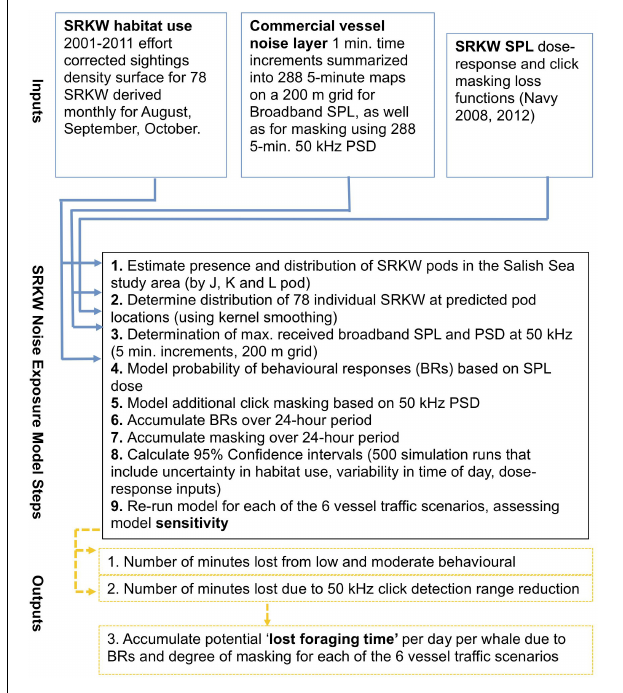
FIGURE 3 | Explanation and pseudocode of noise-exposure simulation model. More details for each of the 9 steps can be found in the Supplementary Material